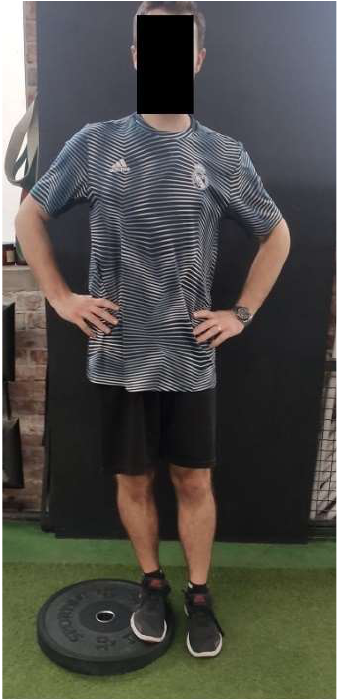
Pelvic drop : starting position—standing on a stable surface with the dominant leg on the edge of a 5 cm box (right side). Participants lower the heel of the non-dominant leg to